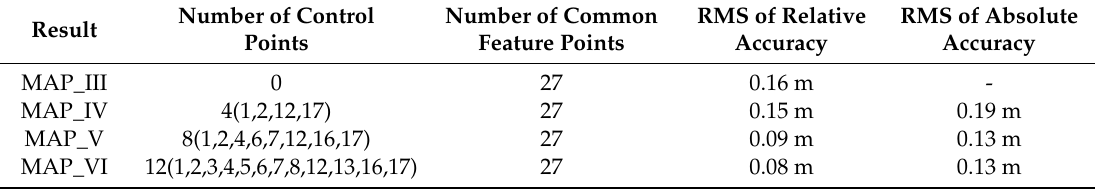
Figure 7. Control point distribution in Block 1. Table 2. RMS comparison of different mapping results (adding different numbers of control points).